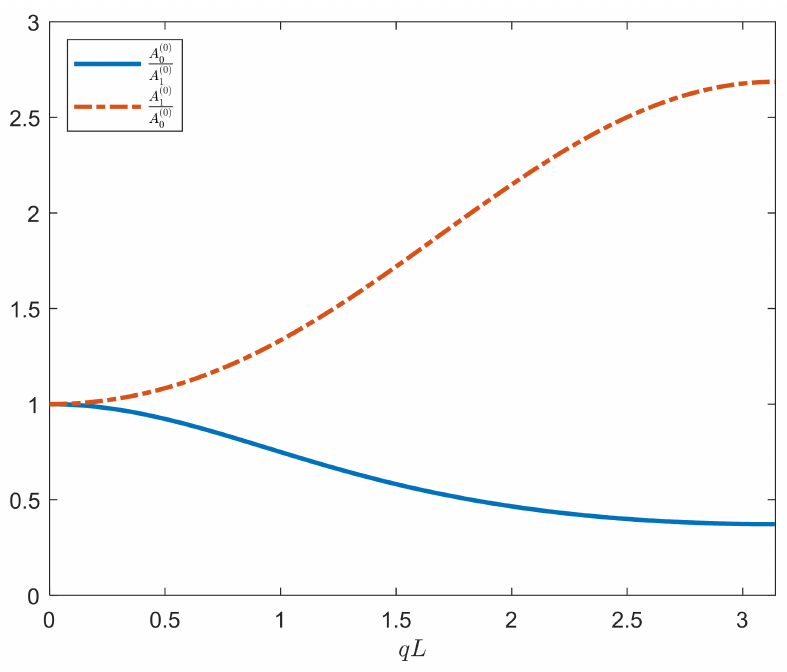
Figure 3. The relationship between the amplitude ratio and the dimensionless wave